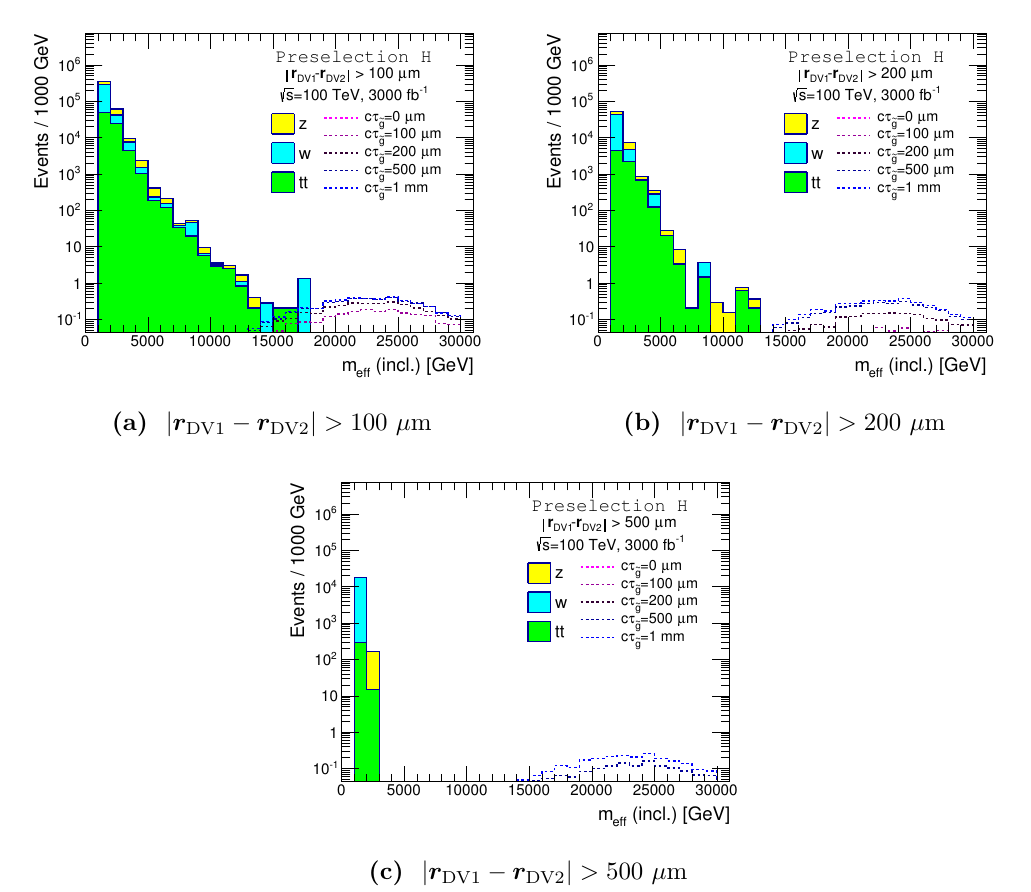
Figure 21. Distributions of m e(cid:11) (incl : ) for the SM background and signal events with di(cid:11)erent values of c(cid:28) ~ g . The masses of gluino and the LSP are set to be 14 TeV and 100 GeV, respectively. We have imposed preselection-H and the vetoes given in table 6.